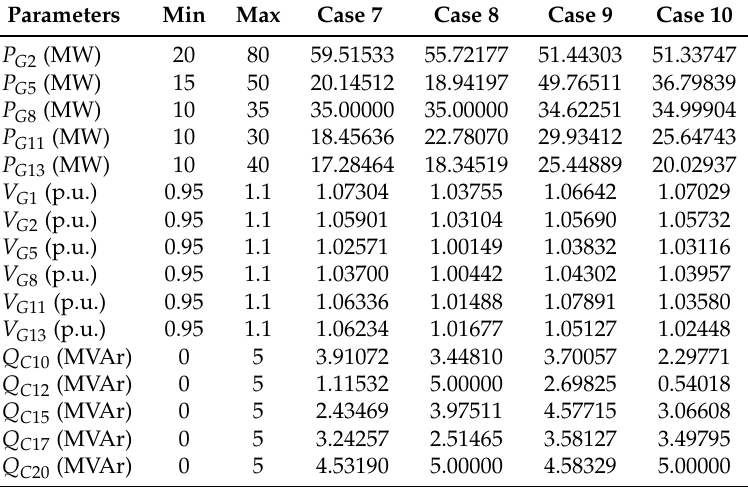
Table A8. Optimal solutions obtained by GROM for multi-objective OPF for IEEE 30-bus system.